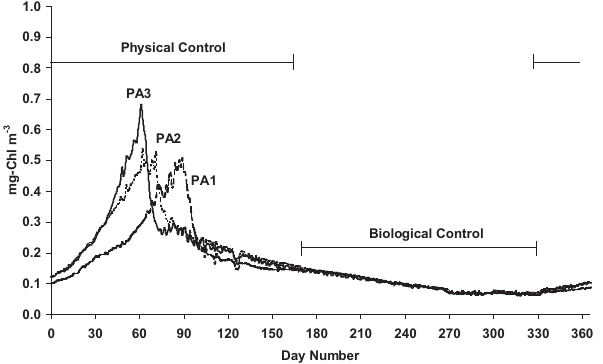
Fig. 6. Chlorophyll concentrations for the runs PA1, PA2 and PA3 showing the periods under physical and biological control.